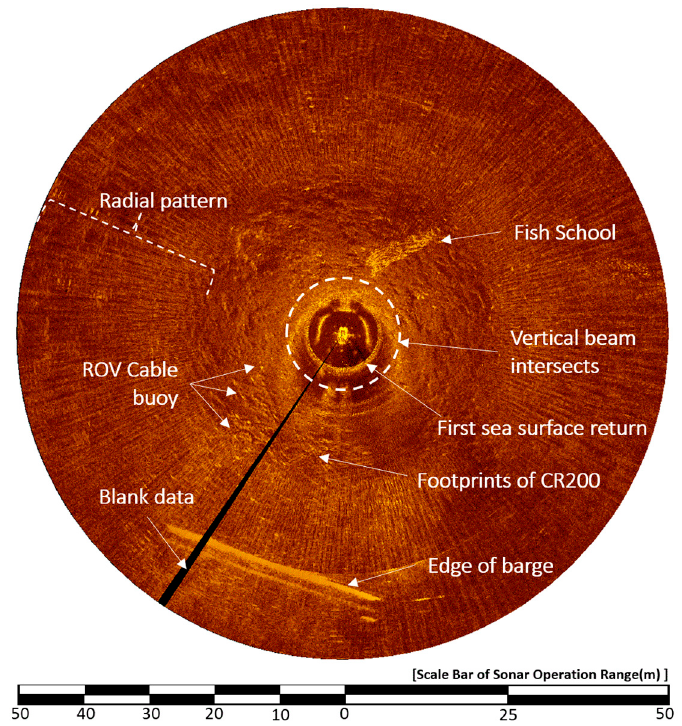
Figure 18. Result image of the horizontal posture.